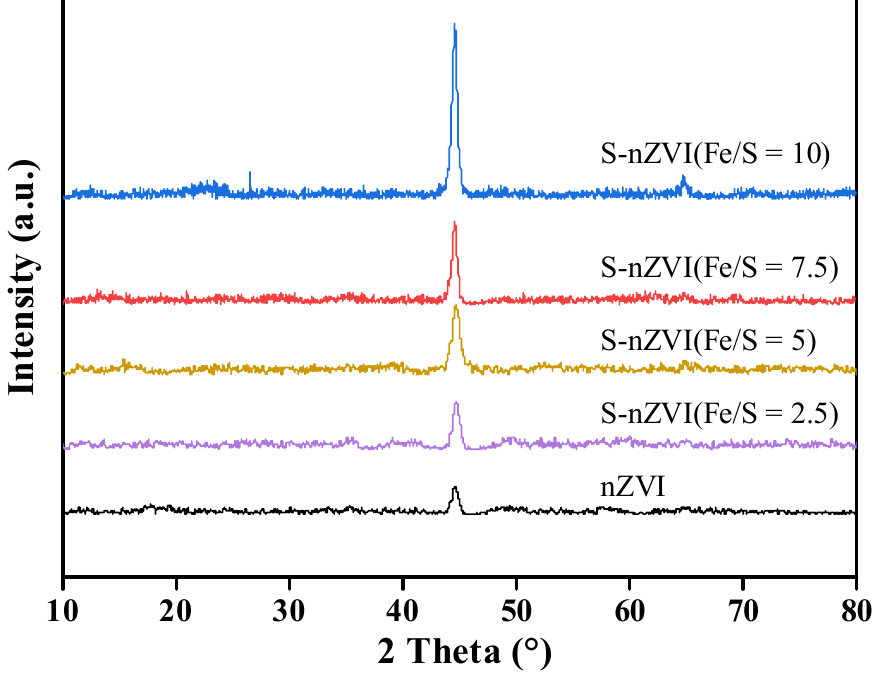
Figure 2. XRD spectra of nZVI and S-nZVI materials with different Fe/S molar ratios.